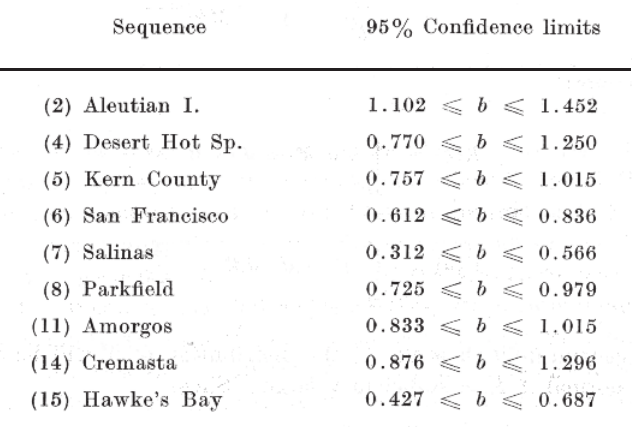
Table 11. Confidence limits on the frequency